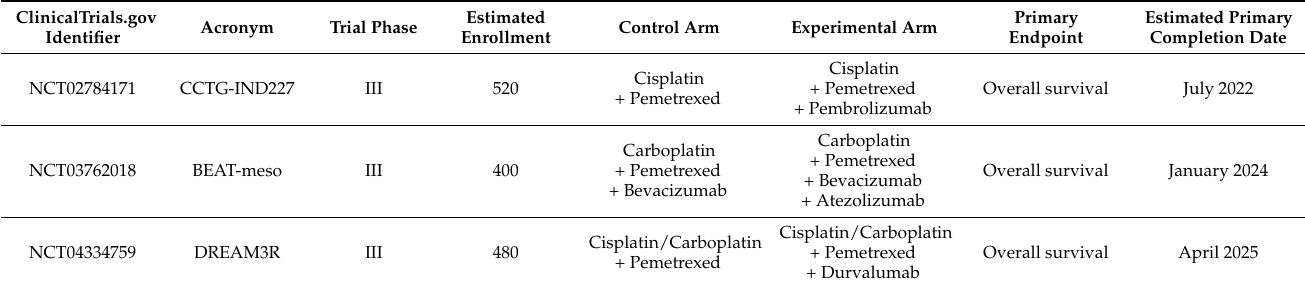
Table 2. Ongoing Phase III chemotherapy combined with immune checkpoint inhibitor trials in advanced malignant pleural